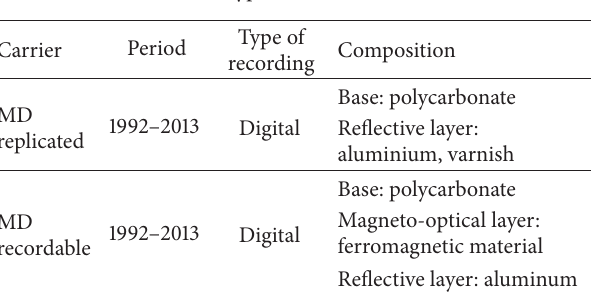
Table 6: Types of MiniDiscs